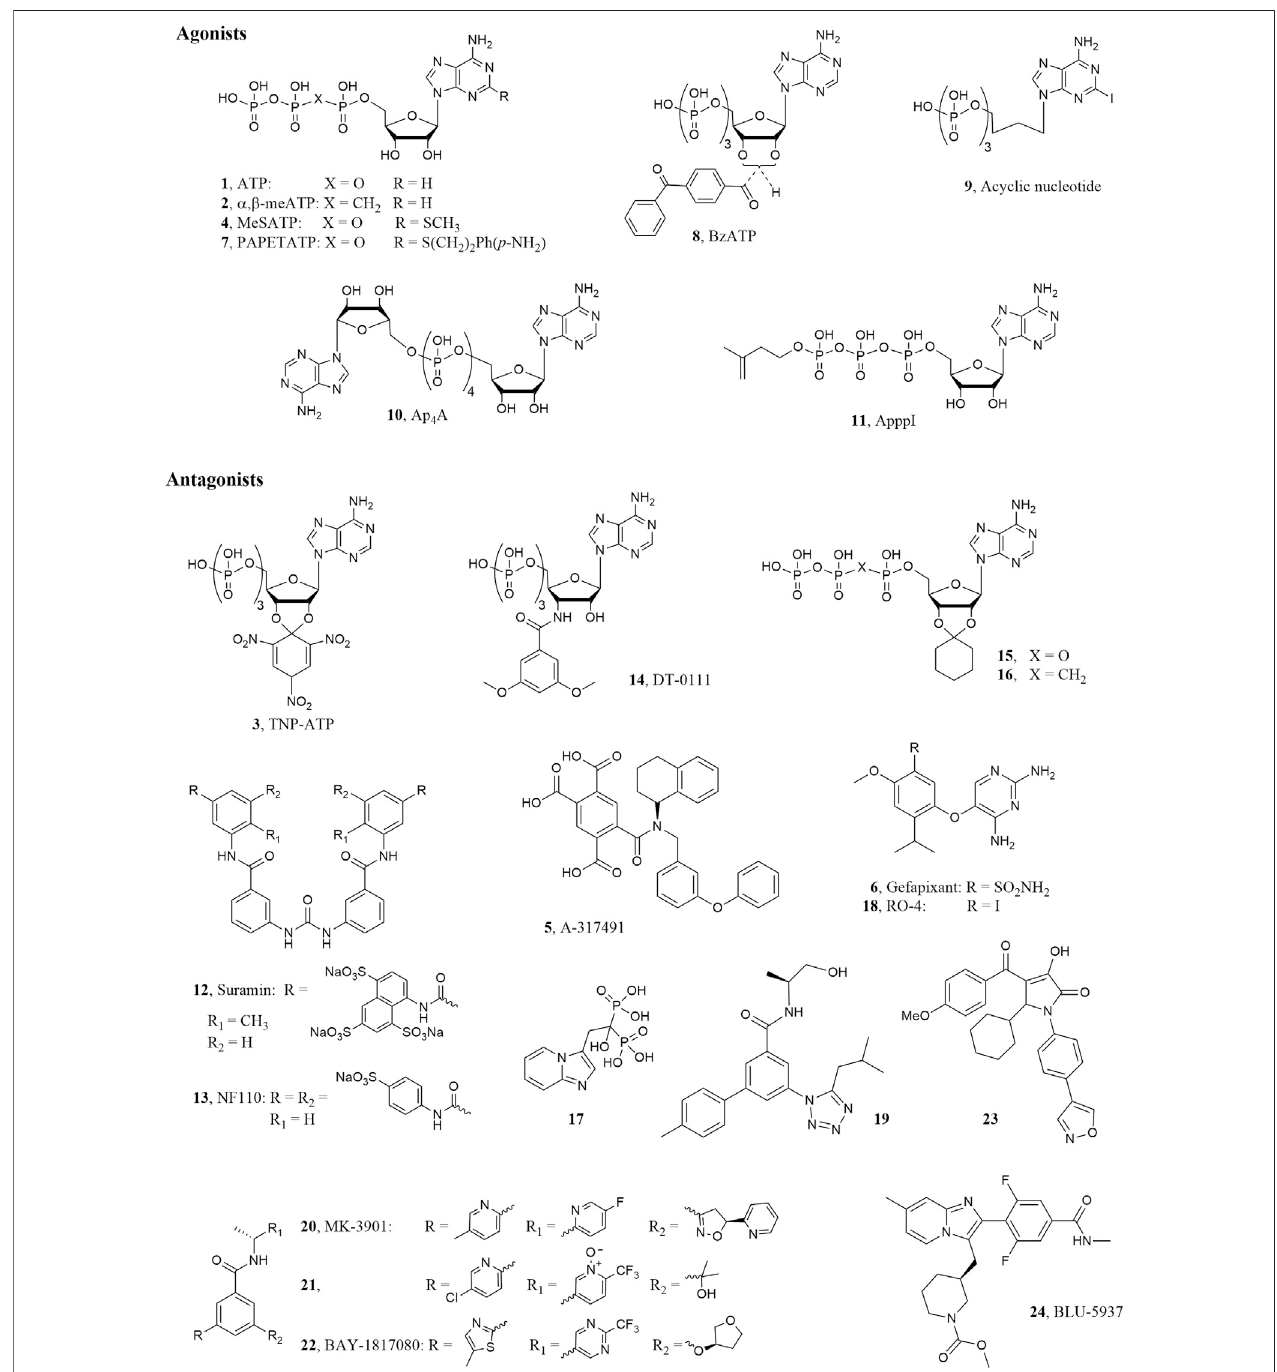
FIGURE 1 | P2X3R ligand